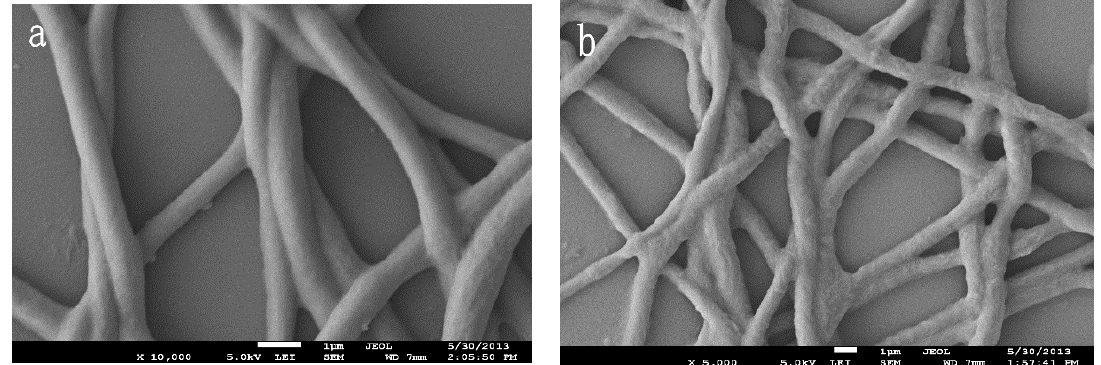
Figure 4. SEM morphology of molecular imprinted nanofibers after crosslinking (( a ) before elution; and ( b ) after elution).